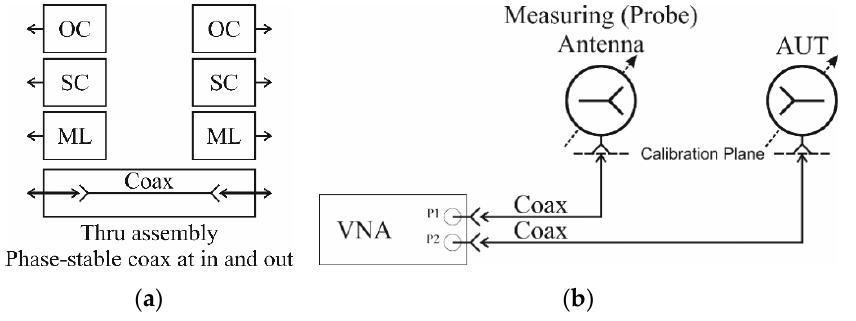
Figure 7. Dynamic calibration: ( a ) full two-port SOLT calibration standards with defined thru; ( b ) generalized antenna measurement diagram with 2P VNA. ( b ) generalized antenna measurement diagram with 2P